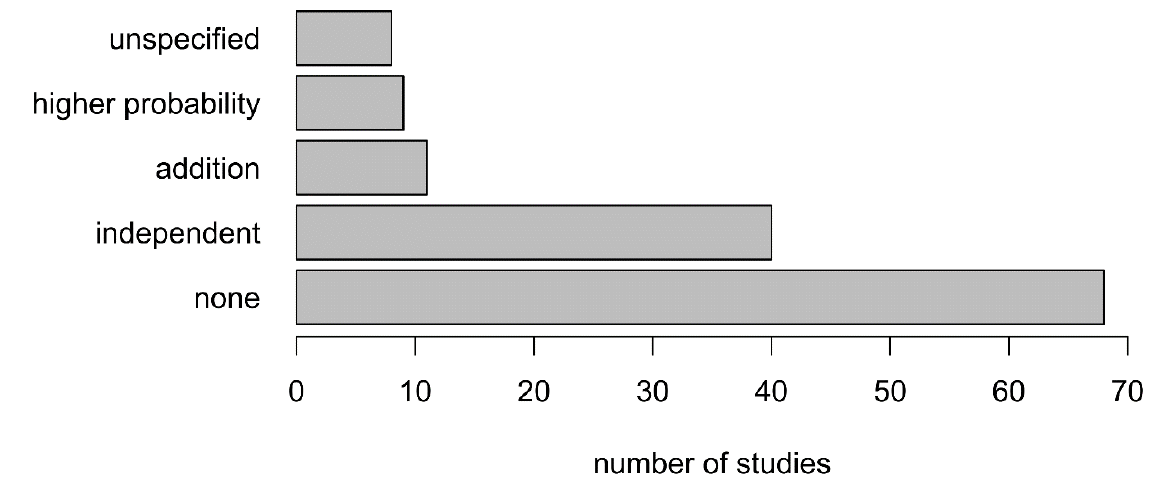
Figure 6. Number of studies reviewed by type of one-class classifiers combination.